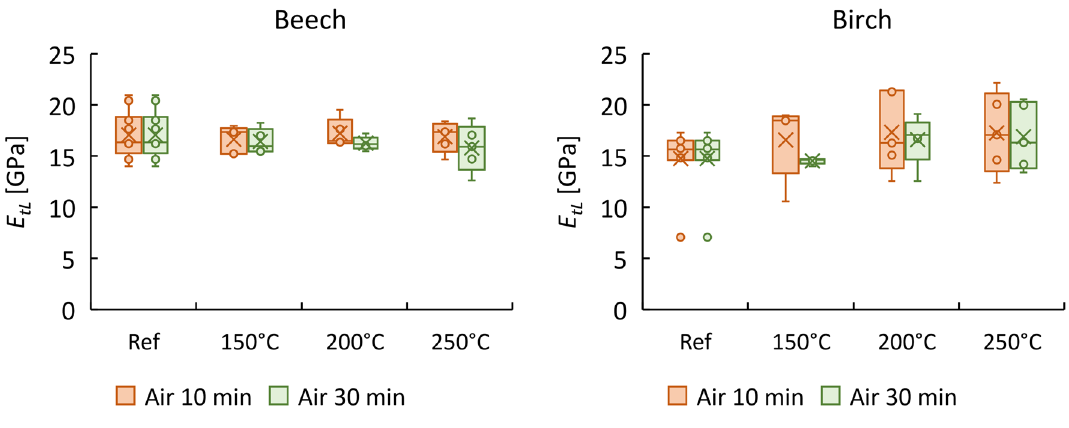
Figure 6. Tensile modulus of elasticity ( E tL ) of beech and